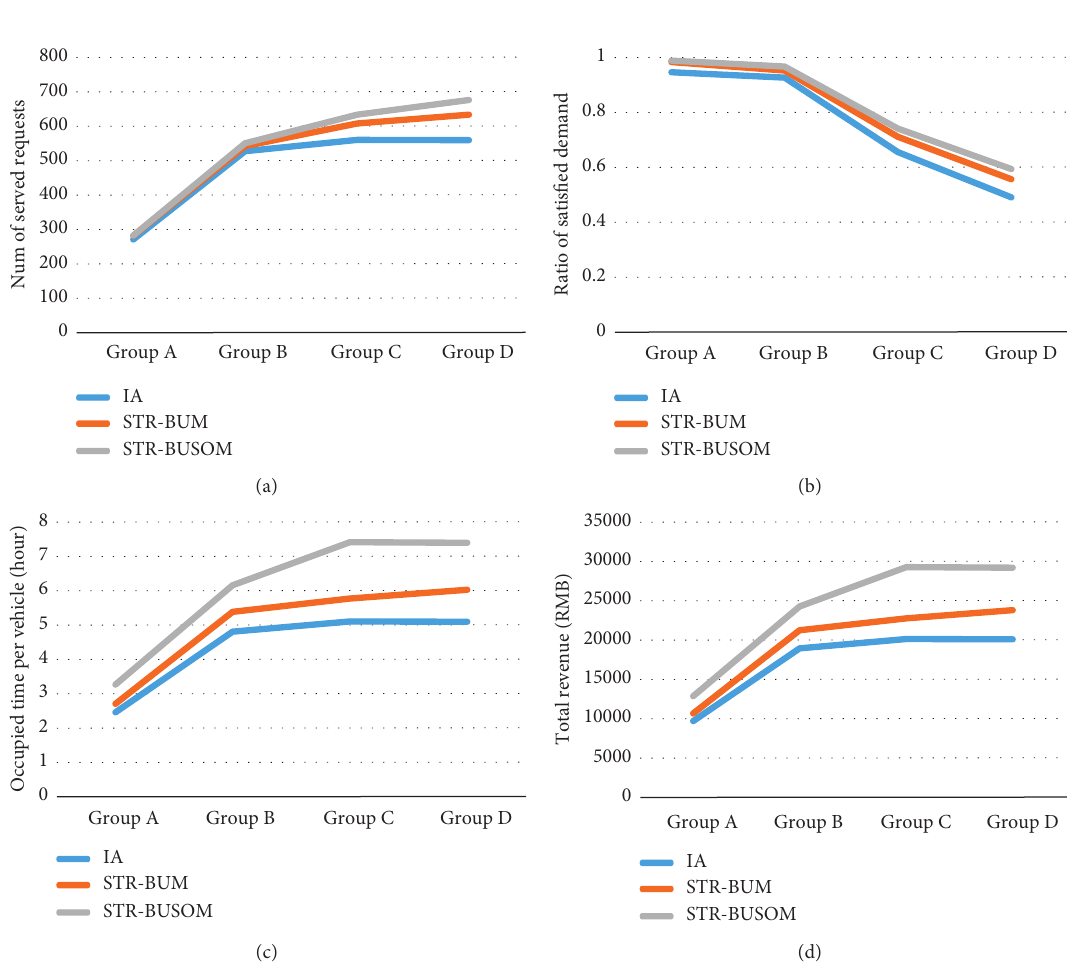
Figure 13: Performance and capacity under different demand intensity. (a) Number of served requests. (b) Ratio of satisfied demands to total demands. (c) Average occupied time per vehicle. (d) Total